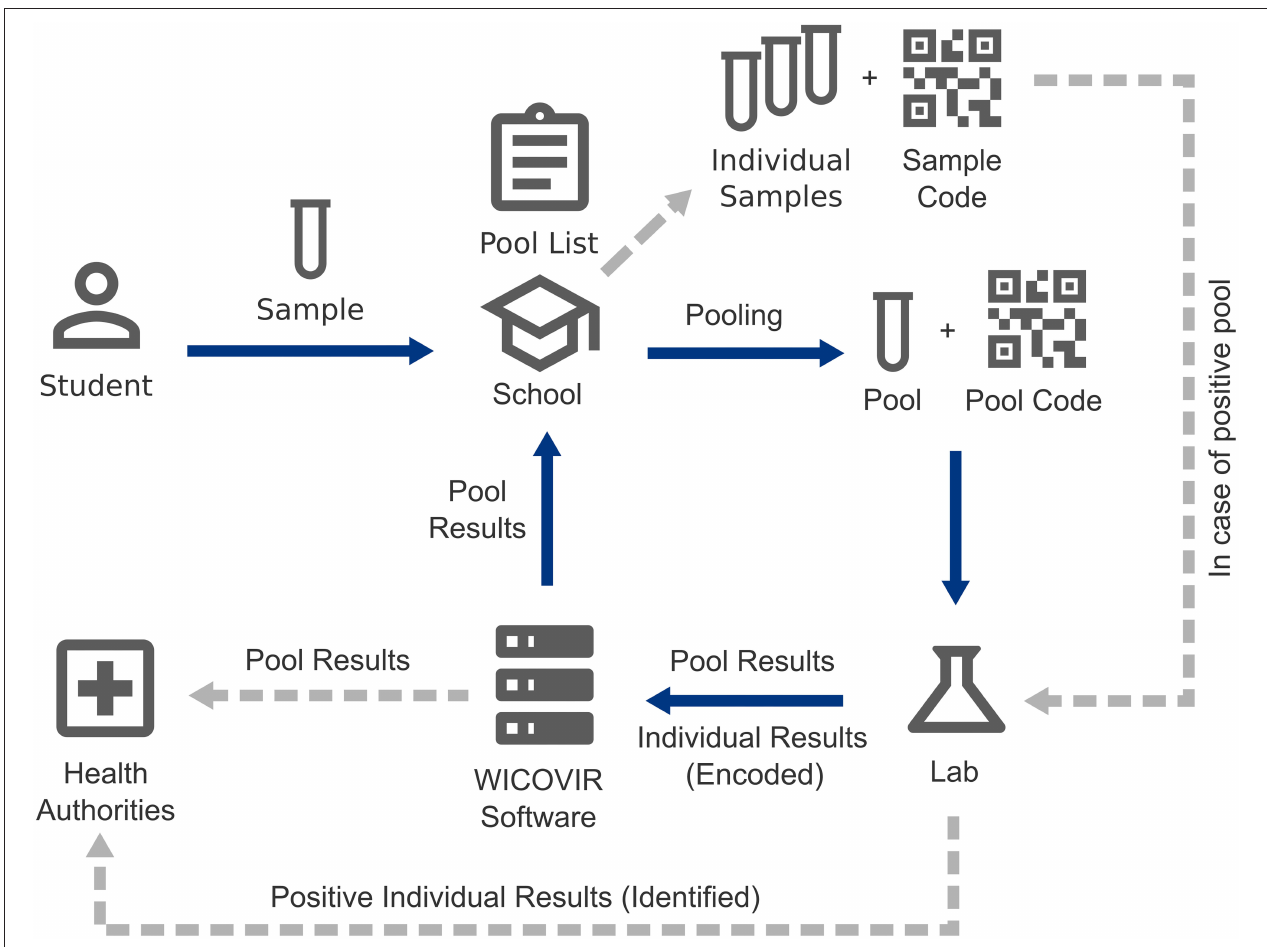
FIGURE 3 | Sample/data flow and data protection. Student samples were pooled in the participating schools, who kept analog records of pool participants and registered pools in the software. Pools were barcoded and sent to the lab. Pool test results were documented in the software by the lab and schools received results through the software. In the case of a positive pool, individual samples pertaining to a positive pool were sent to the lab and individual results were entered into the software in a pseudonymized fashion. Health authorities had access to the pseudonymized data in the software and received personalized results directly from the labs through official reporting